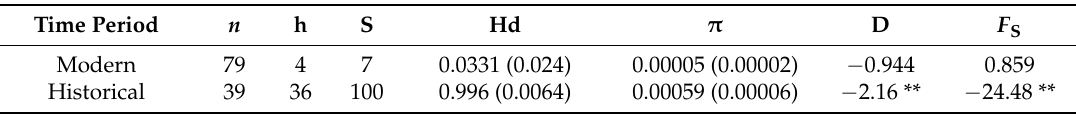
Table 1. Overall genetic diversity indices for 118 historical and modern k¯ak¯ap¯o mitogenomes (16,588 bp) showing the sample size ( n ), number of observed haplotypes (h), number of polymorphic sites (S), haplotypic diversity (Hd), nucleotide diversity ( π ) with their respective standard error (SE) in brackets and Tajima’s D and Fu’s F S .